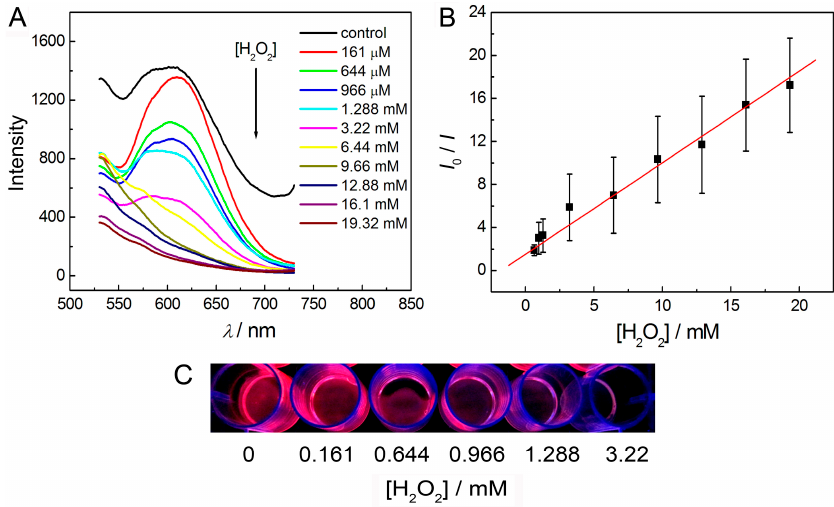
Figure 9. Detection of H 2 O 2 using AuNCs-based solid membrane: ( A ) luminescence quenching of the AuNCs with the addition of different amounts of H 2 O 2 (the concentrations of H 2 O 2 are 0–19.32 mM from top to bottom) on AuNCs-based membrane; ( B ) the values of I 0 / I as a function of the concentration of H 2 O 2 ; ( C ) a photograph showing the visual detection of H 2 O 2 in the concentration range of 0–3.22 mM.